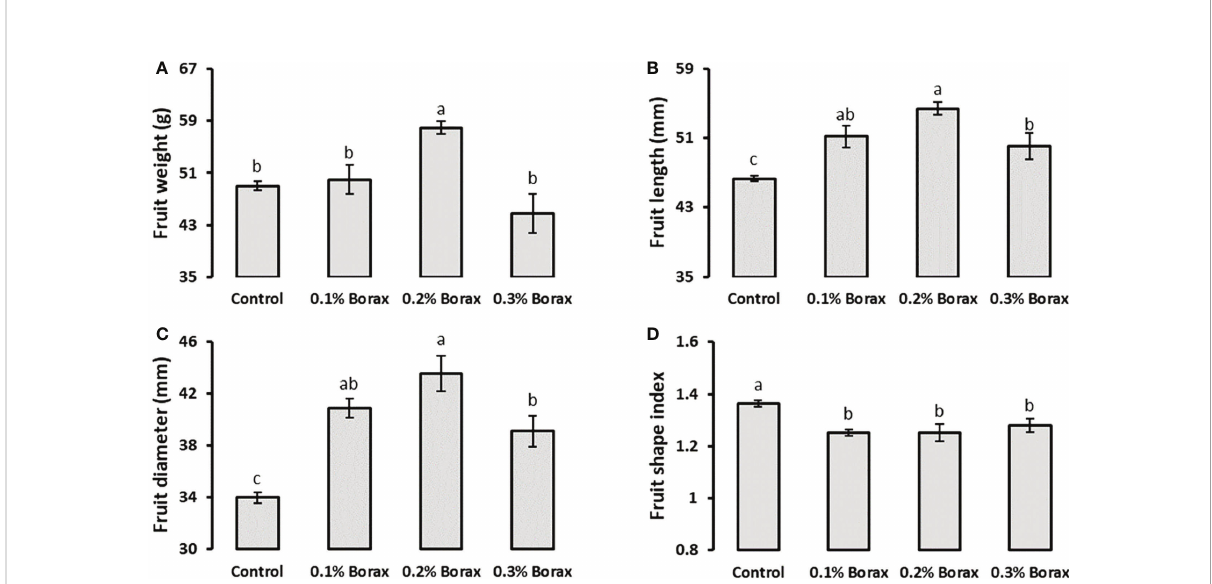
FIGURE 1 Effect of foliar application of B on weight (A) , length (B) , diameter (C) , and shape index (D) of loquat fruits. Loquat plants were foliar sprayed with B twice at blooming stage. Same letters indicate non-signi fi cant difference among treatments according to Fisher ’ s least signi fi cant difference (LSD) test, when p ≤ 0.05 . Vertical bars indicate mean ± standard error (n=4, 4-block RCBD